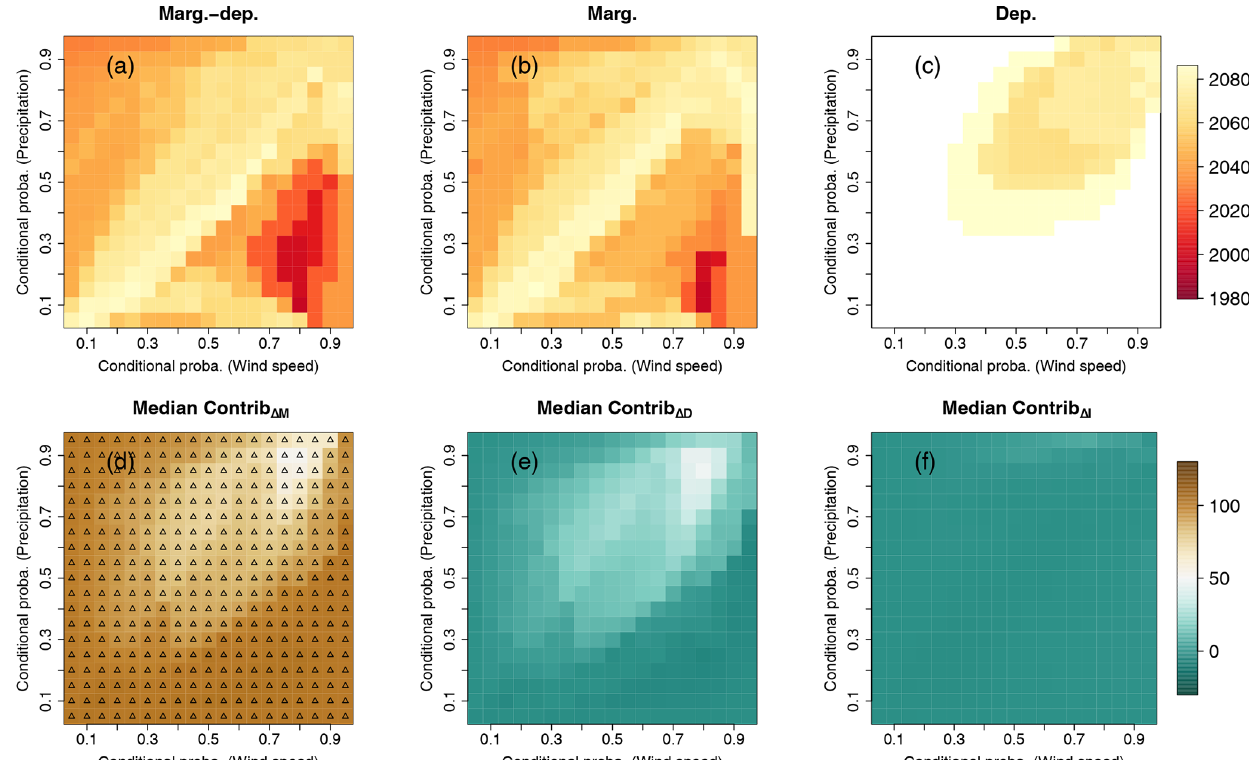
Figure 8. Time of emergence (at 68% confidence level) matrices of compound wind and precipitation extremes for the Indiv-Ensemble version due to changes of (a) both marginal and dependence properties, (b) marginal properties only, and (c) dependence properties only. Results are displayed for varying exceedance thresholds between the 5th and 95th percentile of compound wind and precipitation extremes data. For (a–c) , white indicates that no time of emergence is detected. Median contributions of (d) marginal, (e) dependence and (f) interaction terms. Upper triangles show where contribution is ≥